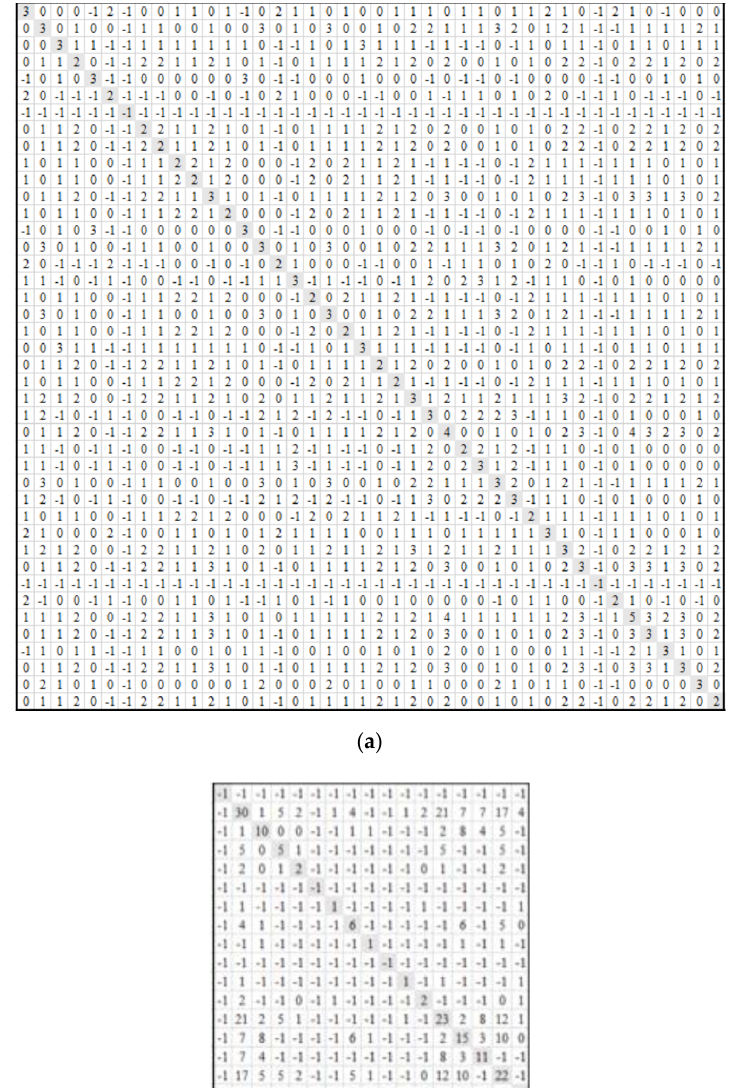
Figure 6. ( a ) TU shared face matrix ( b ) State shared face matrix. Each number in the matrix represents the dimension of the face (number of common vertices-1) that each TU or state shares with other TUs or states and 1 indicates no shared face, a face of 0 indicates a single vertex in common between pairs of simplices.